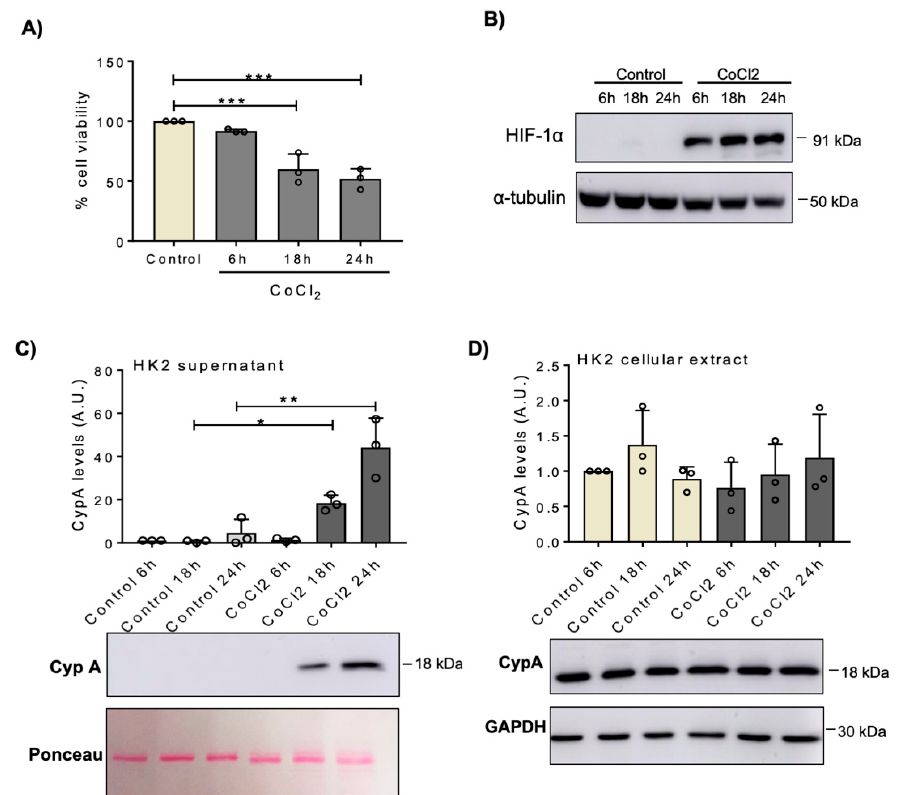
Figure 1. CypA is released by cultured human proximal tubular HK2 cells under chemical hypoxia. HK2 cells were exposed to 500 µ M CoCl 2 for the indicated periods of time. ( A ) Cell viability was assessed by the MTT assay. ( B ) HIF-1 α expression, a marker of hypoxia, was assessed by Western blot. ( C , D ) Western blot of CypA in cell supernatants ( C ) and in cellular extracts ( D ). Quantification and representative image. ( A , C , D ) Mean ± SD of three independent experiments. * p < 0.05; ** p < 0.01; *** p < 0.001. Uncropped gel scans shown in Figure S1A.